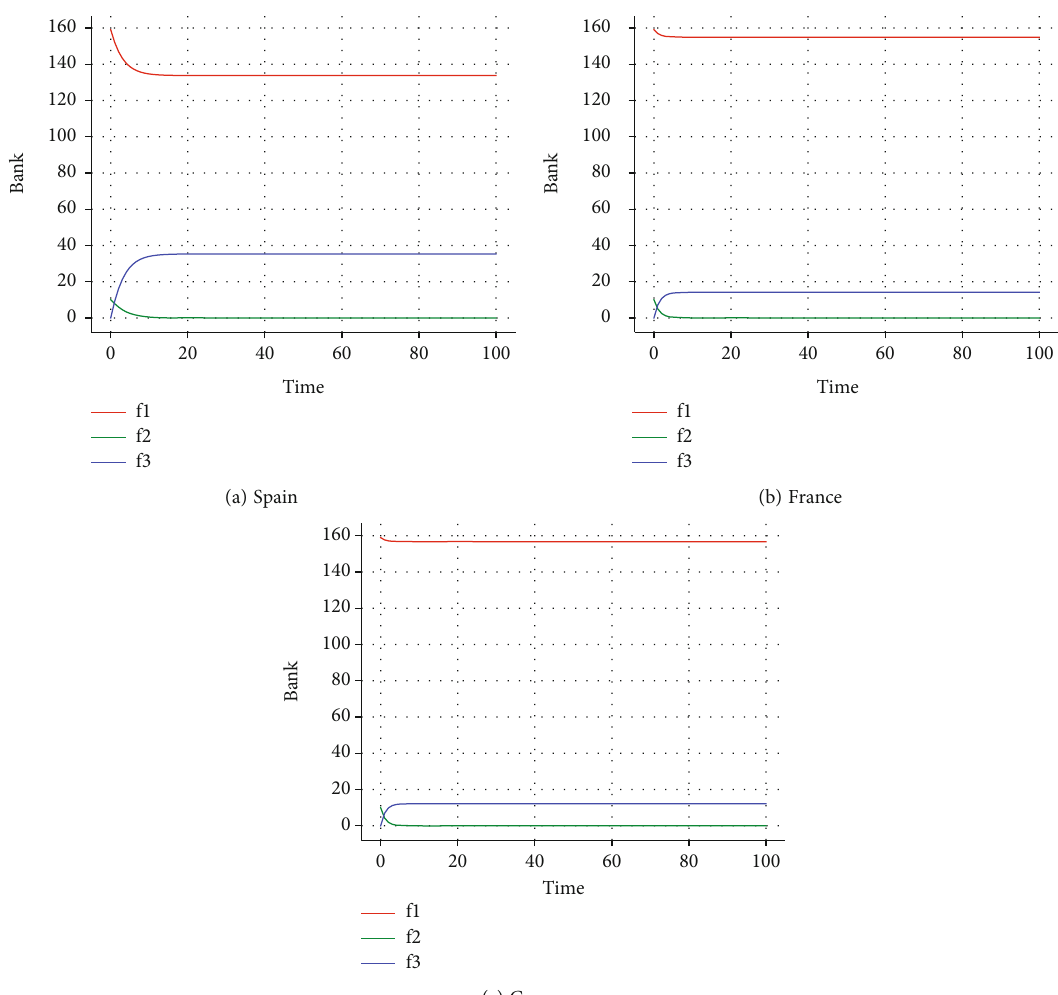
Figure 2: Liquidity risk in Spain, France, and Germany behavior over time with α